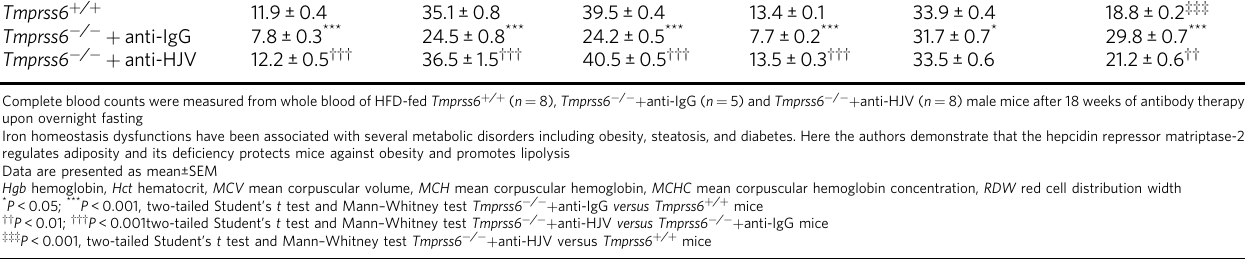
Table 1 Hematologic parameters of HFD-fed Tmprss6 + / + and Tmprss6 − / − mice treated with anti-IgG or anti-HJV antibodies